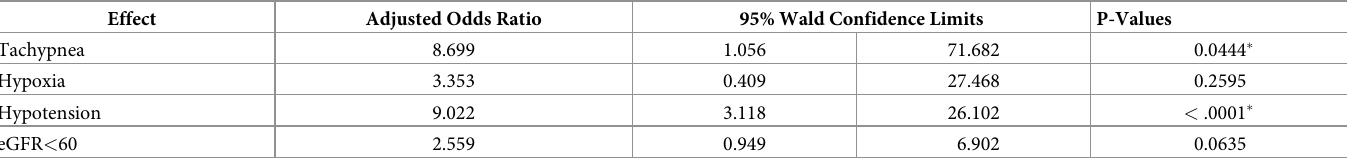
Table 9. Symptoms, signs, and findings associated with in-hospital mortality. Multivariate stepwise regression for patients who did not have severe disease or die in the first day of hospitalization (n=223).